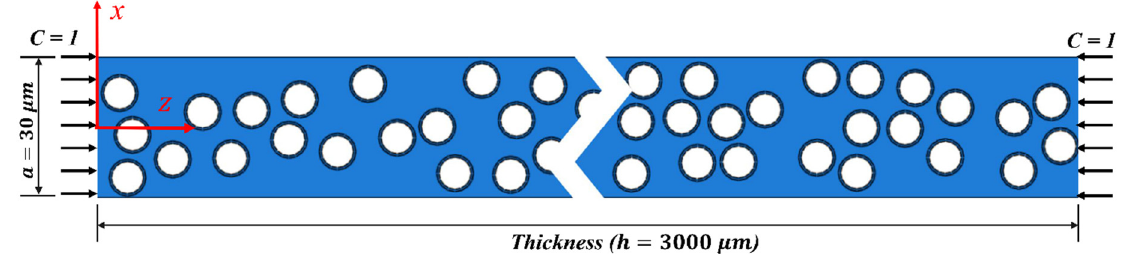
Figure 4: Schematic of the numerical model used to simulate the transient moisture di ff usion